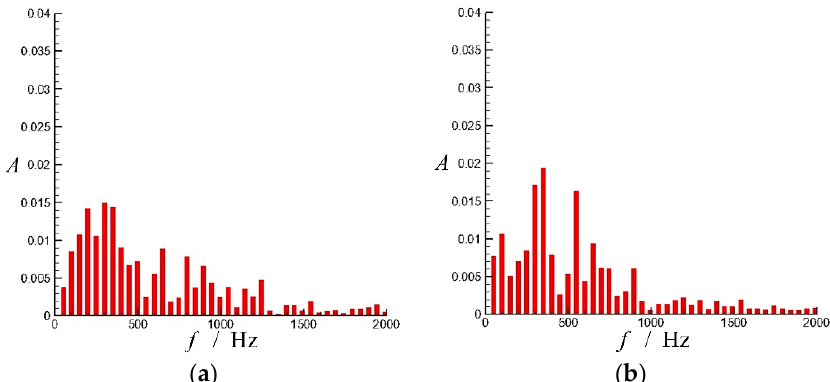
Figure 11. Numerical simulation of the diffuser with invalid control: ( a ) Velocity FFT ( A − f ) of S2 ( (cid:101) V = 0.15, (cid:101) f = 1.04, and f TWW = 380 Hz); ( b ) Velocity FFT ( A − f ) of S2 ( (cid:101) V = 0.28, (cid:101) f = 2, and f TWW = 740